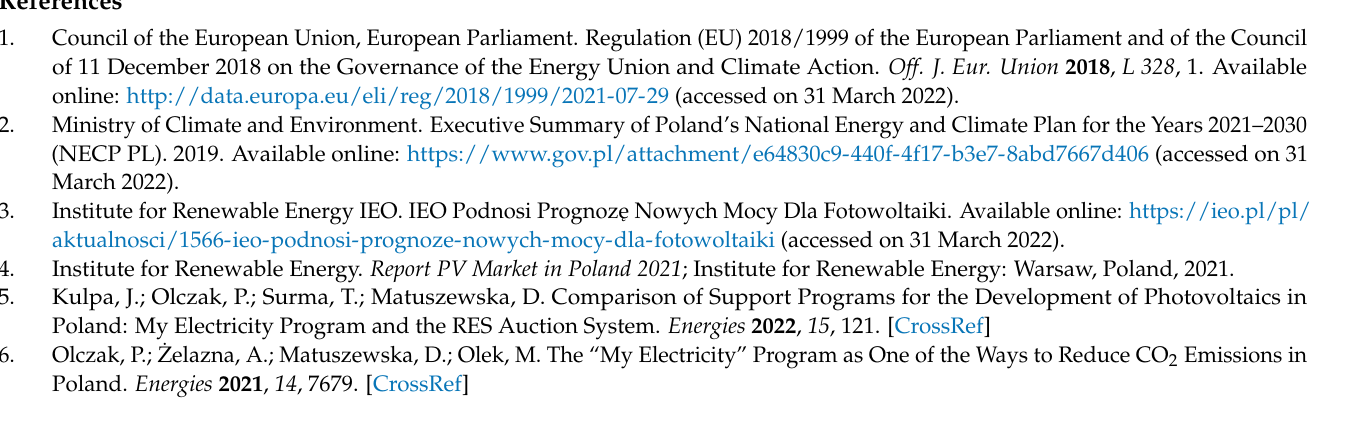
Figure A3. Schematic diagram of the PV9 system.